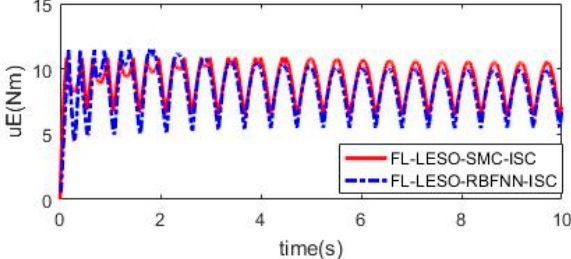
Figure 13. VSJ angle deviation.